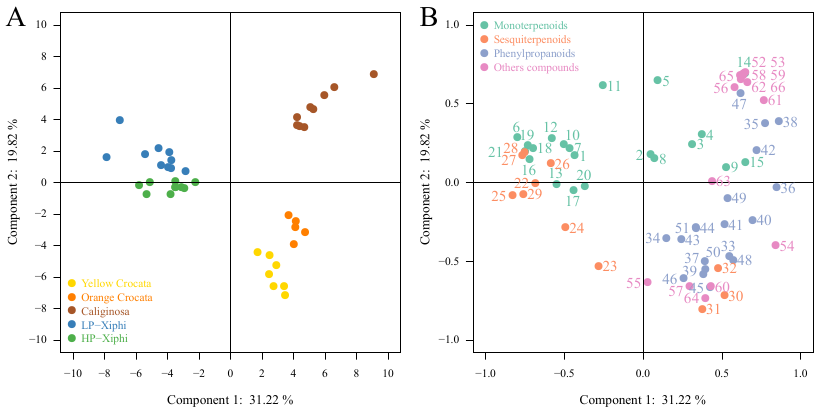
Figure 2. PCA based on VOCs emitted from yellow crocata, orange crocata, caliginosa, HP-xiphi and LP-xiphi: ( A ) Score plot of PC1 versus PC2 scores. ( B ) Loading plot of PC1 and PC2 contributing volatile compounds.